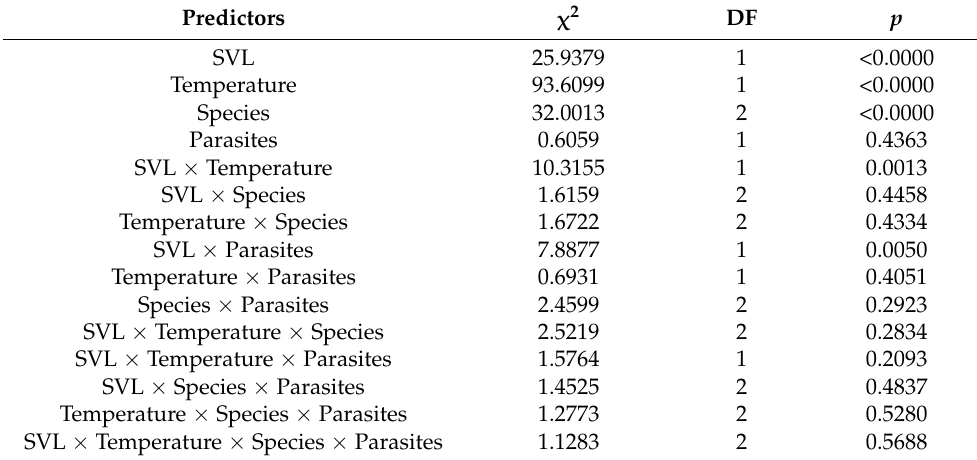
Table 1. Main and interactive effects of snout-vent length (SVL), temperature, species, and log 10 parasite load on the maximum jumping distance of frogs. These statistical results are from a linear mixed model that also included the identification number of individual frogs as a random